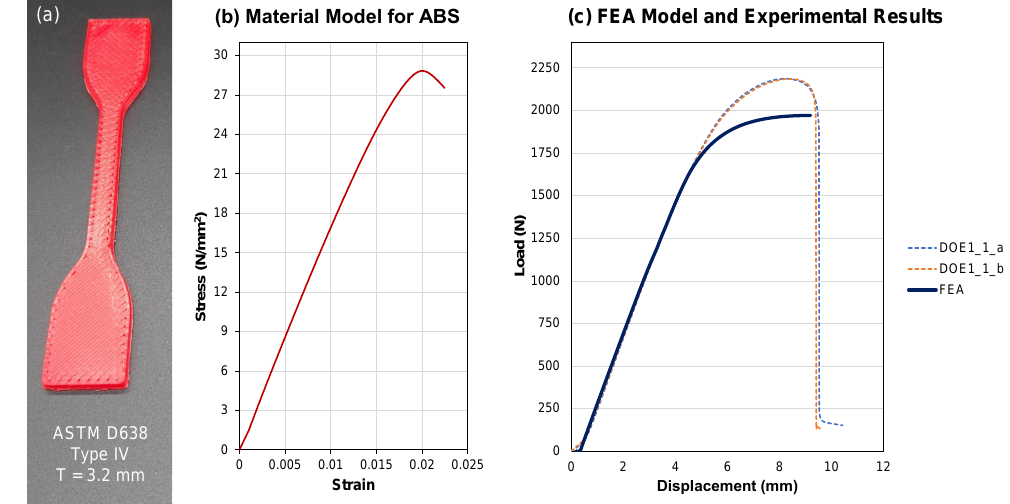
Figure 15. ( a ) Tested sample for material model, ( b ) the material model used for the FEA, and ( c ) Comparison of FEA and experimental